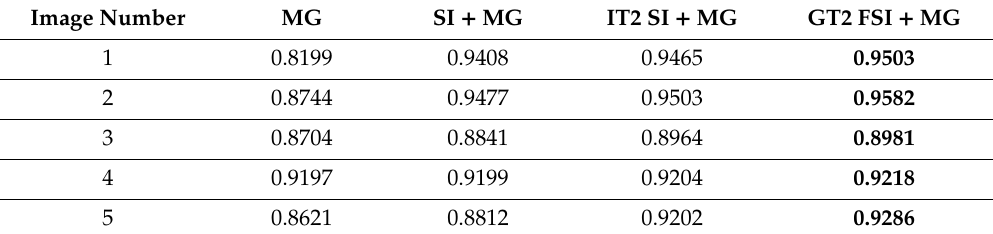
Table 10. "Figure of merit" (FOM) metric calculated using di ff erent edge detectors in synthetic images. Image Number